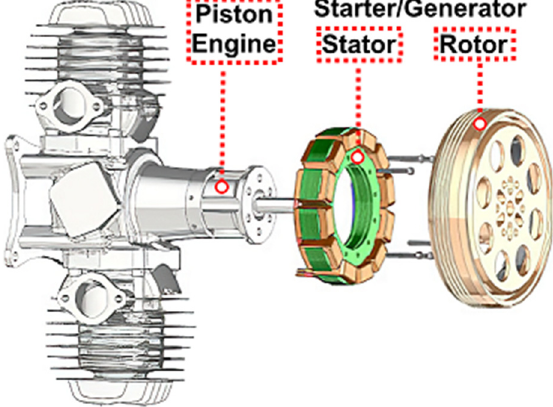
Figure 1. Simple hybrid UAV illustration with the Sullivan S676 Starter/Generator.